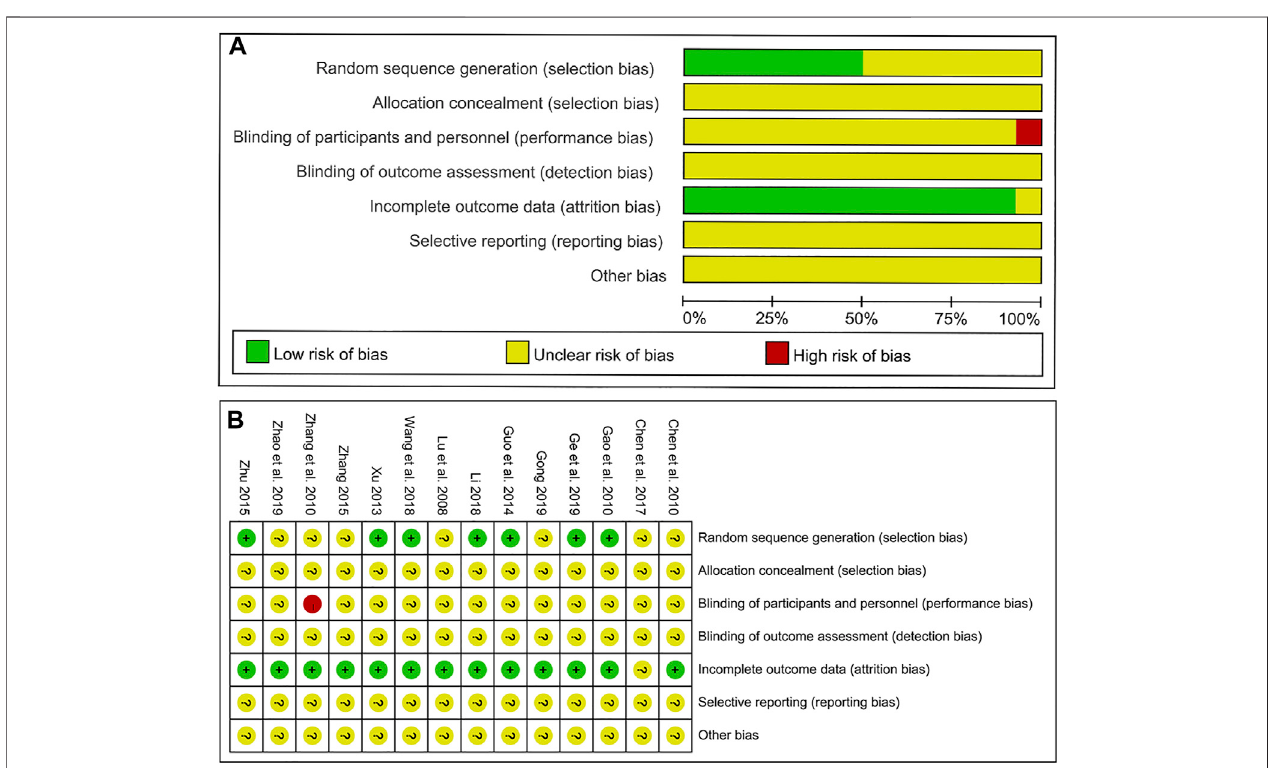
FIGURE 2 | Resultsof the risk of bias assessment of the original literature included in the meta-analysis. (A) Overall risk of bias assessment results. (B) Risk of bias results for each speci fi c original study.